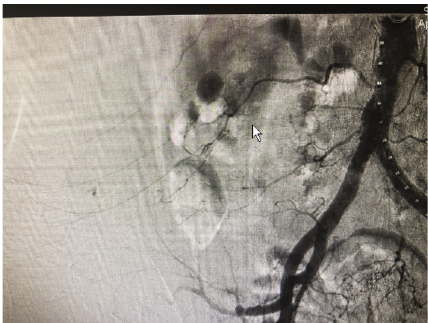
Figure 5: Digital subtraction angiography screenshot for the second patient; there is a visible pseudoaneurysm.